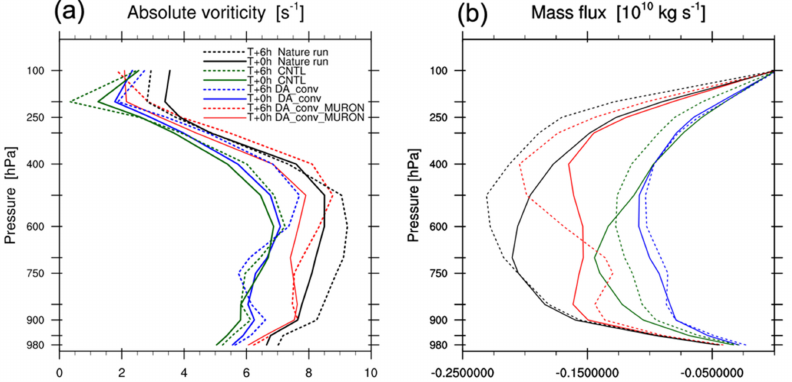
Figure 11. Vertical profiles of ( a ) absolute vorticity and ( b ) mass flux averaged over the 500 km × 500 km box centered on the TC for the nature run (solid black line), the control run (solid green line), the DA_CONV analysis (solid blue line), the DA_CONV_MURON analysis (solid red line), and their corresponding 6-h forecasts (dotted lines). The solid lines are valid at 1800 UTC 3 November 2013 and the dotted lines are valid at 0000 UTC 4 November